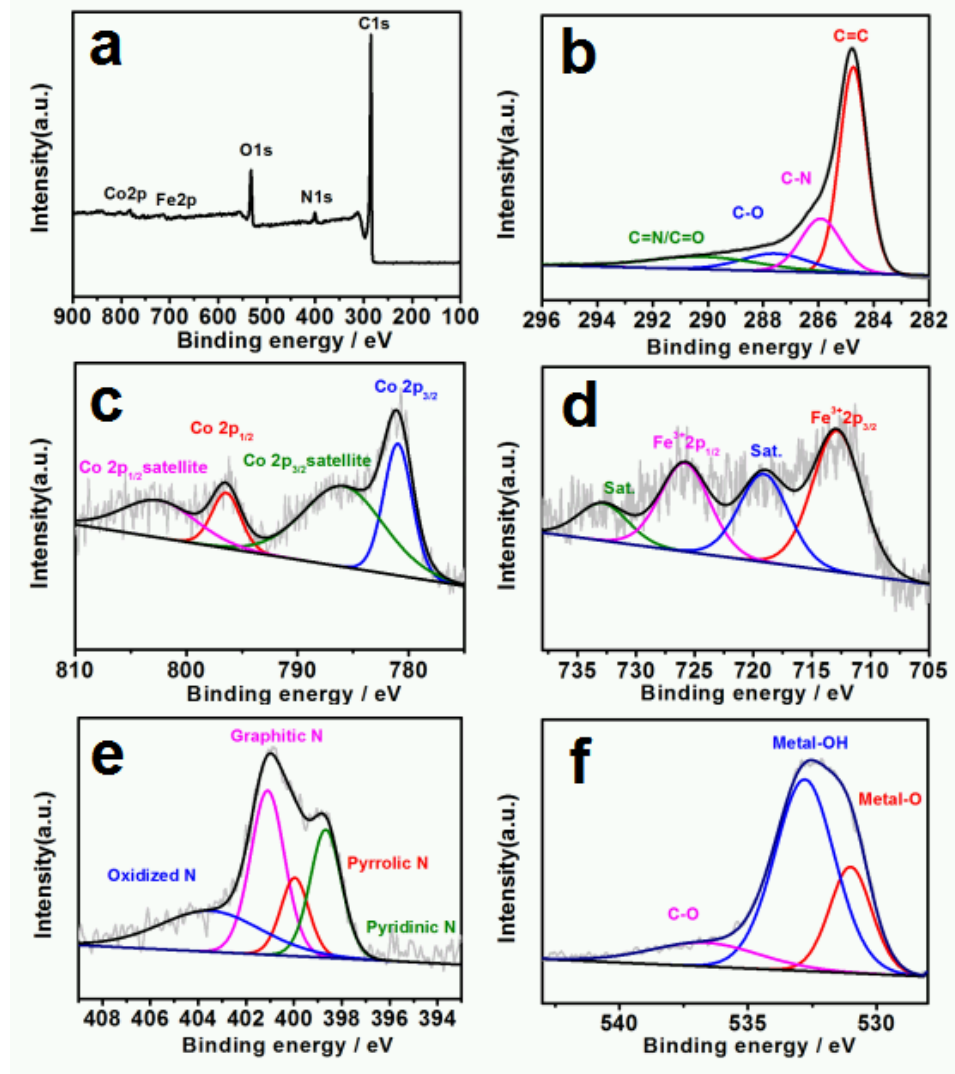
Figure 4. ( a ) Full XPS spectrum of FeCo-N/C (RBC) , deconvoluted. ( b ) C 1s, ( c ) Co 2p, ( d ) Fe 2p ( e ) N 1s and ( f ) O 1s spectra of FeCo-N/C (RBC) .